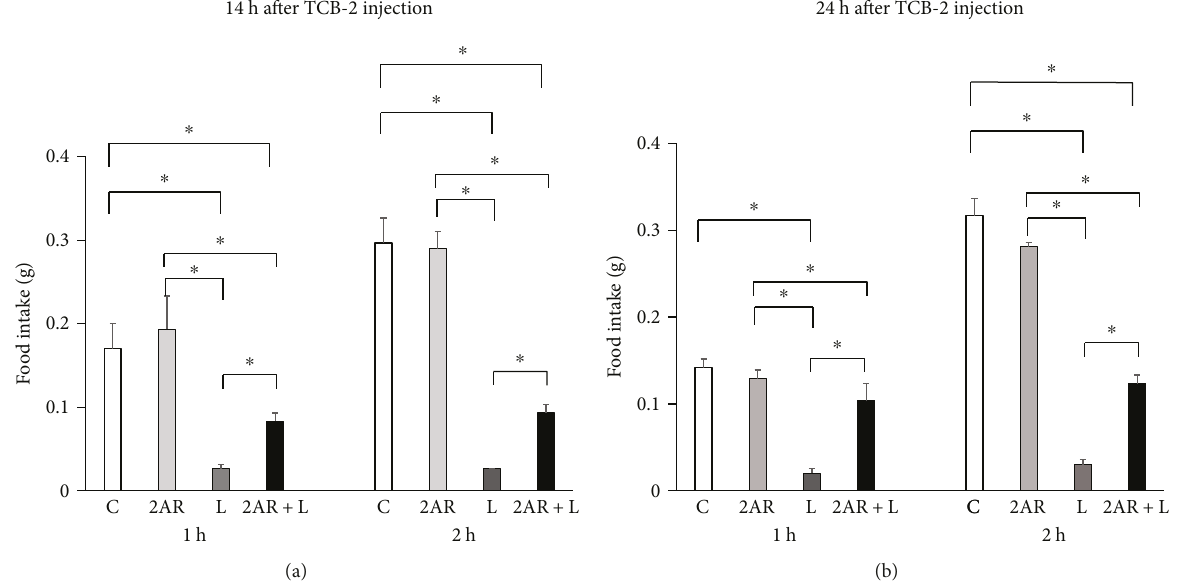
Figure 4: E ff ects of intraperitoneal injection of liraglutide (100 μ g/kg) or saline on food intake in C57BL6J mice intraperitoneally injected with TCB-2 (2.5 mg/kg). Liraglutide was injected 14h later (a) or 24h later (b). Intake of chow pellets was measured for the next hour and then at 2h. Body weight of C57BL6J mice without TCB-2 was 23.9 ± 0.2 g in the saline controls and 24.2 ± 0.3g in the liraglutide-treated group. Body weight of C57BL6J mice treated with TCB-2 was 23.9 ± 0.2g in the saline controls and 24.2 ± 0.3g in the TCB-2 and liraglutide-treated group. C, saline controls; 2AR, TCB-2L treated mice; L, liraglutide-treated mice, and 2AR+L, TCB-2 and liraglutide- treated mice. Data are presented as the mean values ± SEM ( n = 6 /group of animals). ∗ P < 0 05